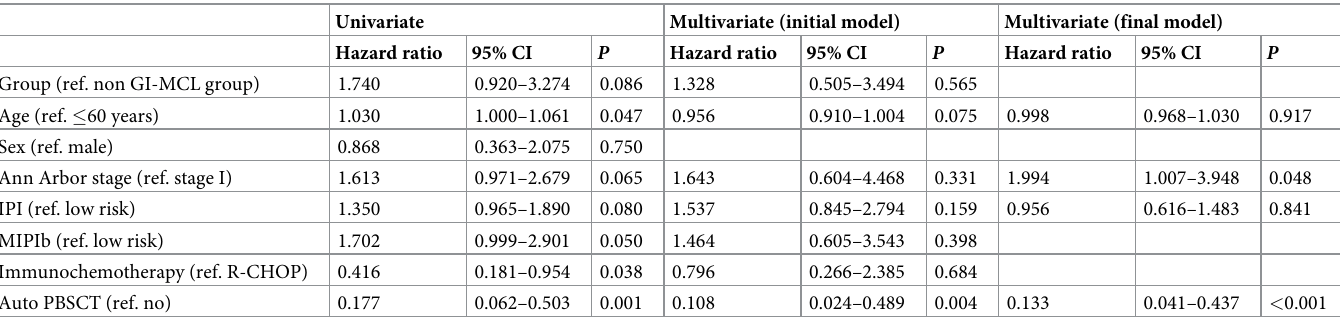
Table 3. Sequential univariate and multivariate Cox proportional hazard regression models, showing independence of effect upon